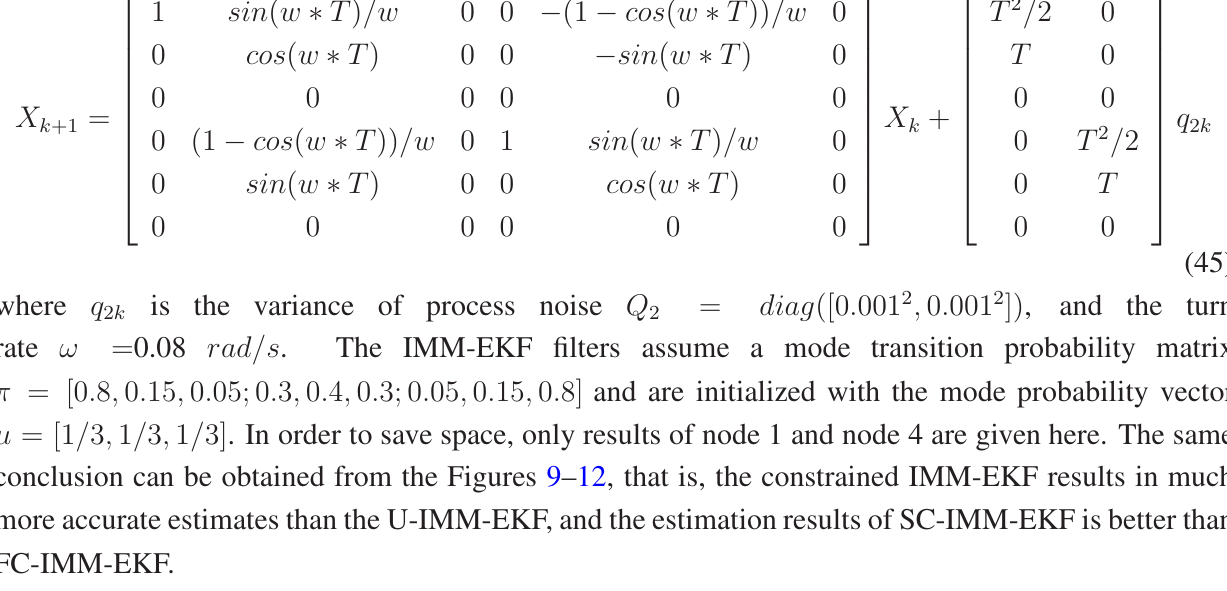
Figure 9. State estimation of node 1.